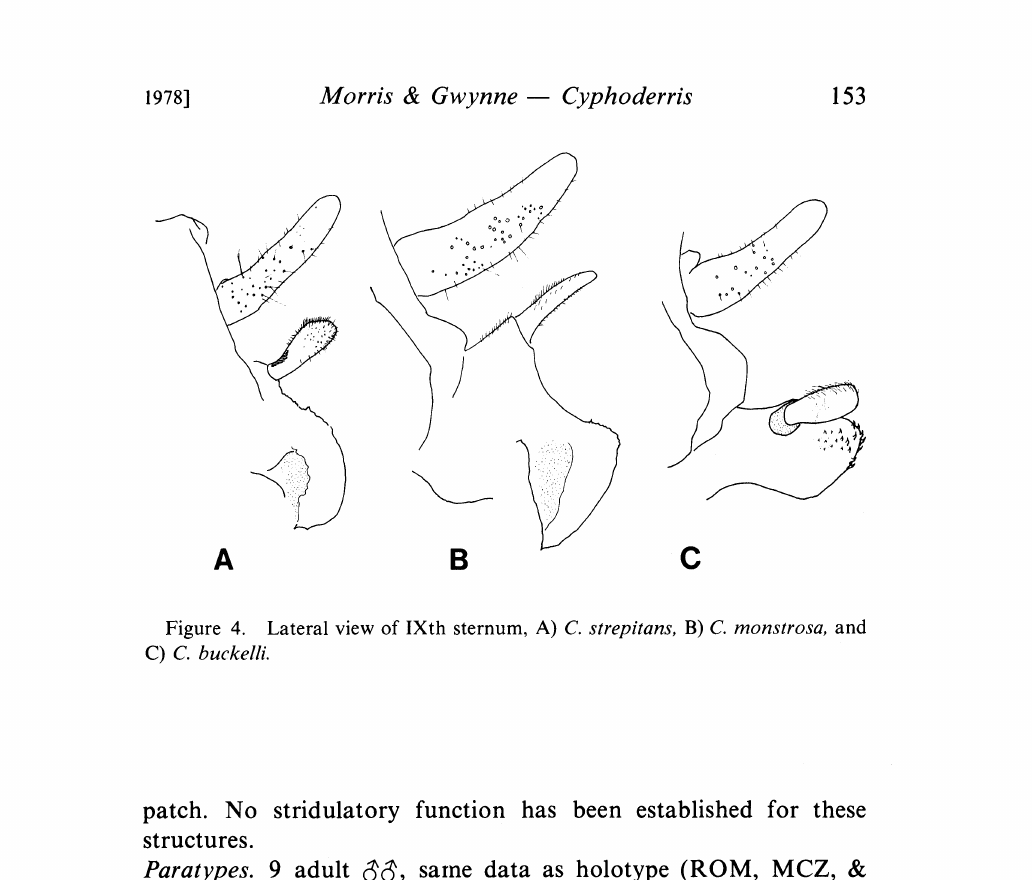
A B C Figure 4. Lateral view of IXth sternum, A) C. strepitans, B) C. monstrosa, and C) C.